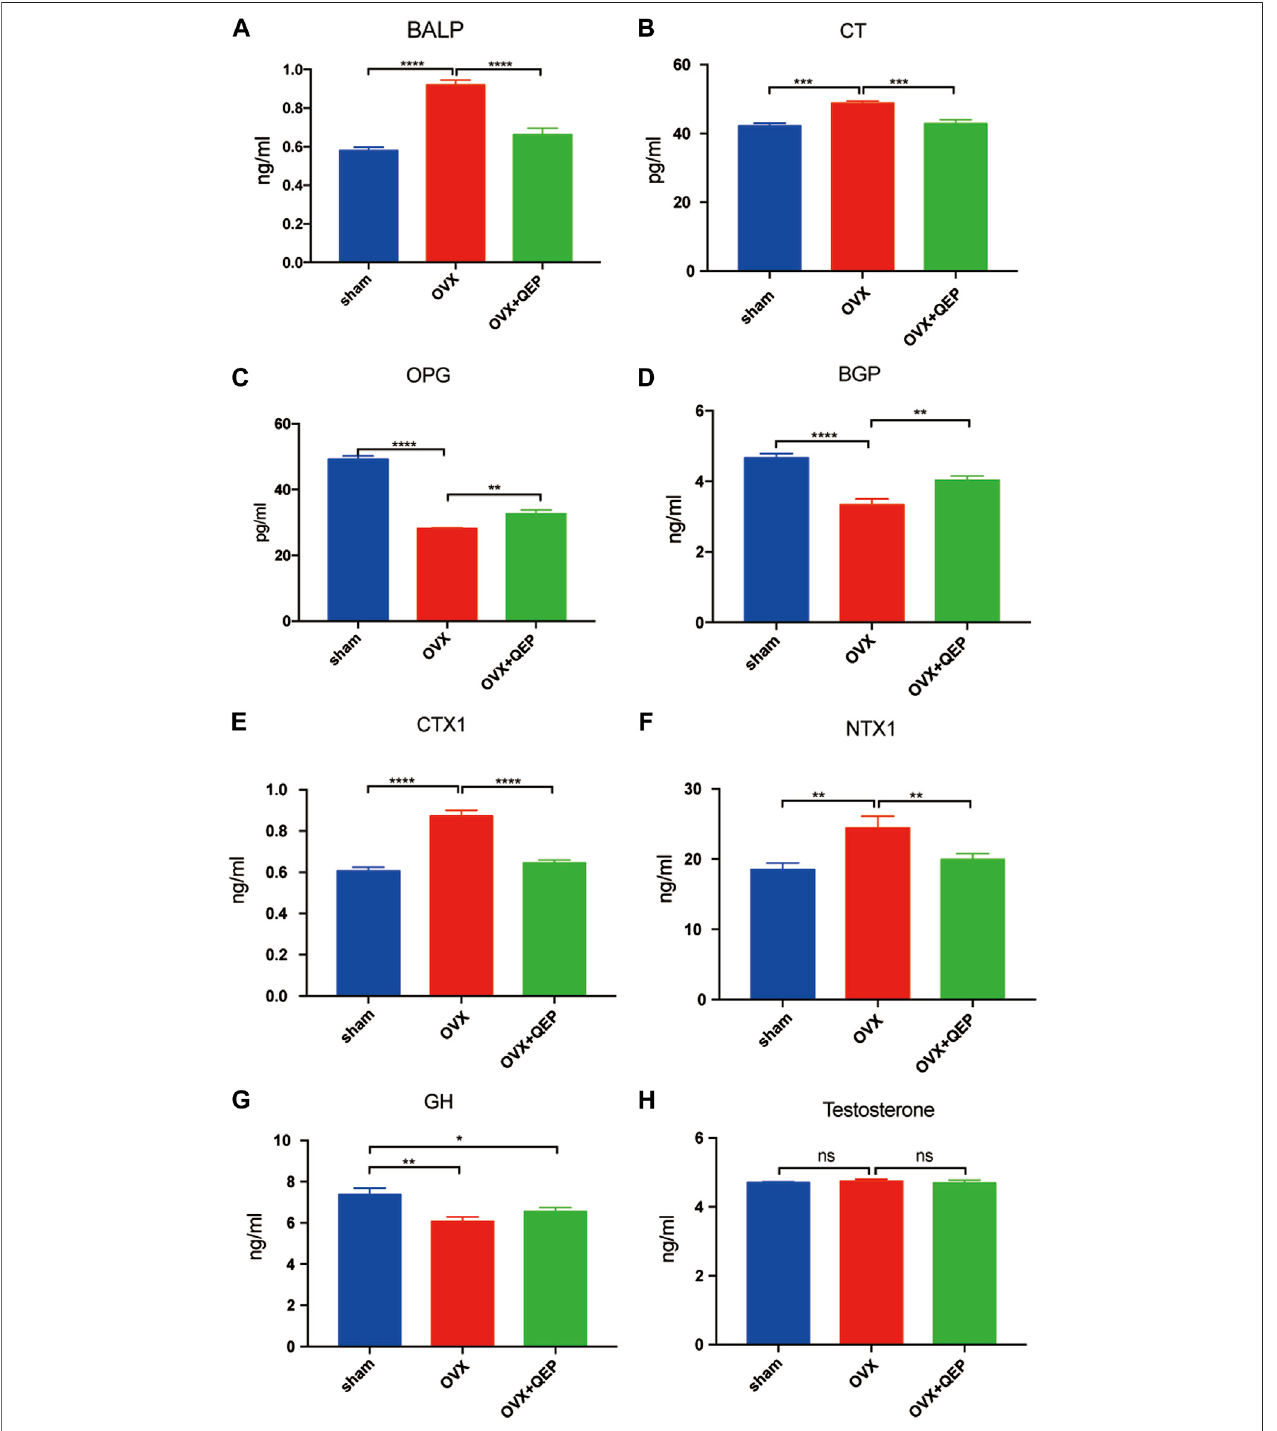
FIGURE7| Theeffect ofQEP onserumosteoporosisindicatorsfromrats. (A) BALP, bonealkaline phosphatase; (B) CT,calcitonin; (C) OPG,osteoprotegerin; (D) BGP, osteocalcin; (E) CTX-1, cross-linked C-telopeptide of type I collagen; (F) NTX-1, cross-linked N-telopeptide of type I collagen; (G) GH, growth hormone; (H) Testosterone. * p < 0.05, ** p < 0.01, *** p < 0.005, and **** p < 0.001. ns p > 0.05, n = 3).